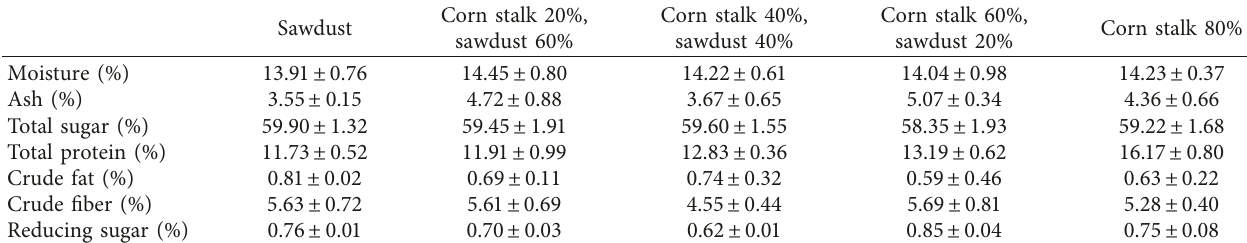
Table 1: Effect of different additions of corn stalks on the macronutrient components of the Auricularia auricula . Corn stalk 20%, Corn stalk 40%, Corn stalk 60%, Sawdust sawdust 60% sawdust 40% sawdust